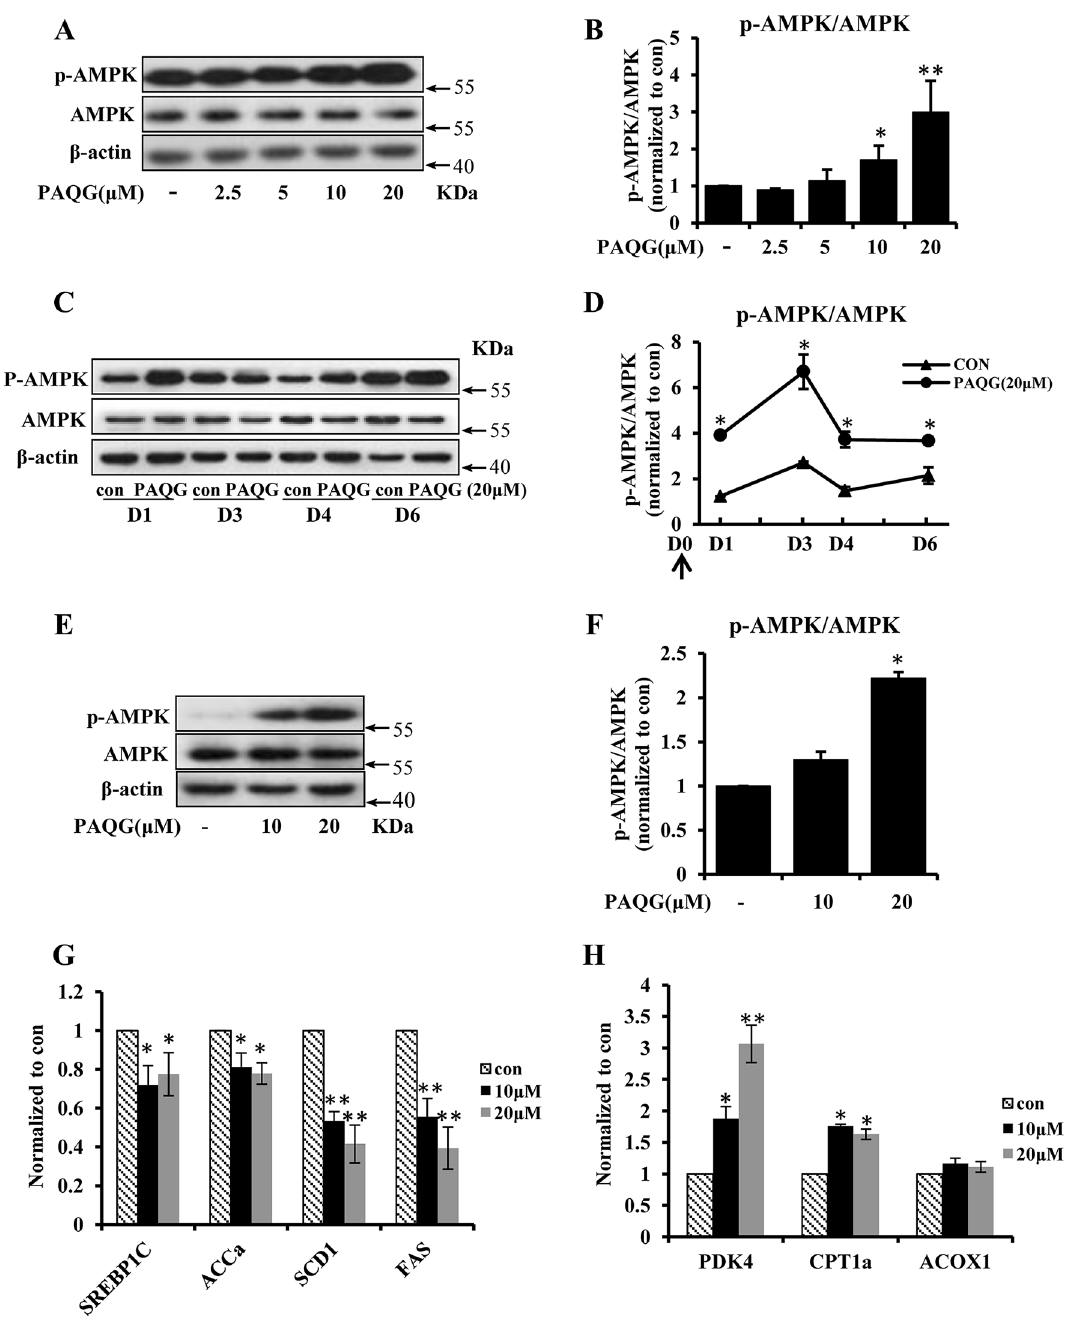
Fig. 4 PAQG activates AMPK pathway in 3T3-L1 adipocytes. a 3T3-L1 pre-adipocytes were induced to differentiate in the presence of indicated concentrations of PAQG. 6 days later, the expression of AMPK and p-AMPK were assessed by western blotting and quantitatively analyzed ( b ). c 3T3-L1 pre-adipocytes were incubated in differentiation medium with 20 l M PAQG or vehicle, the expression of AMPK and p-AMPK were detected at different time during differentiation and quantitatively analyzed ( d ) (the arrow indicates PAQG treatment). Differentiated 3T3-L1 adipocytes were